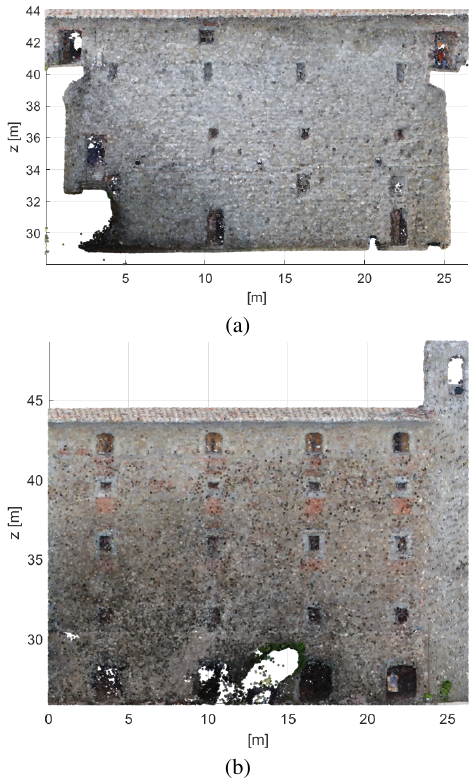
Figure 5. Side views of the central part of the fortress (a) inner wall view, (b) outer wall